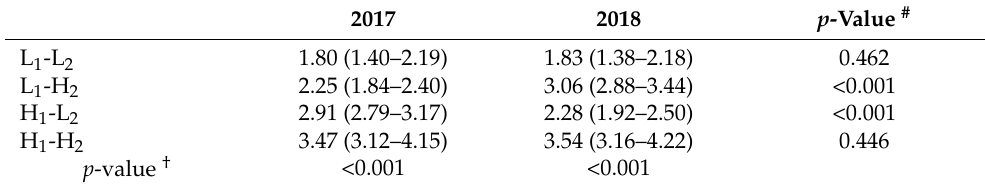
Table 5. The change of water-soluble dietary fiber intake from 2017 to